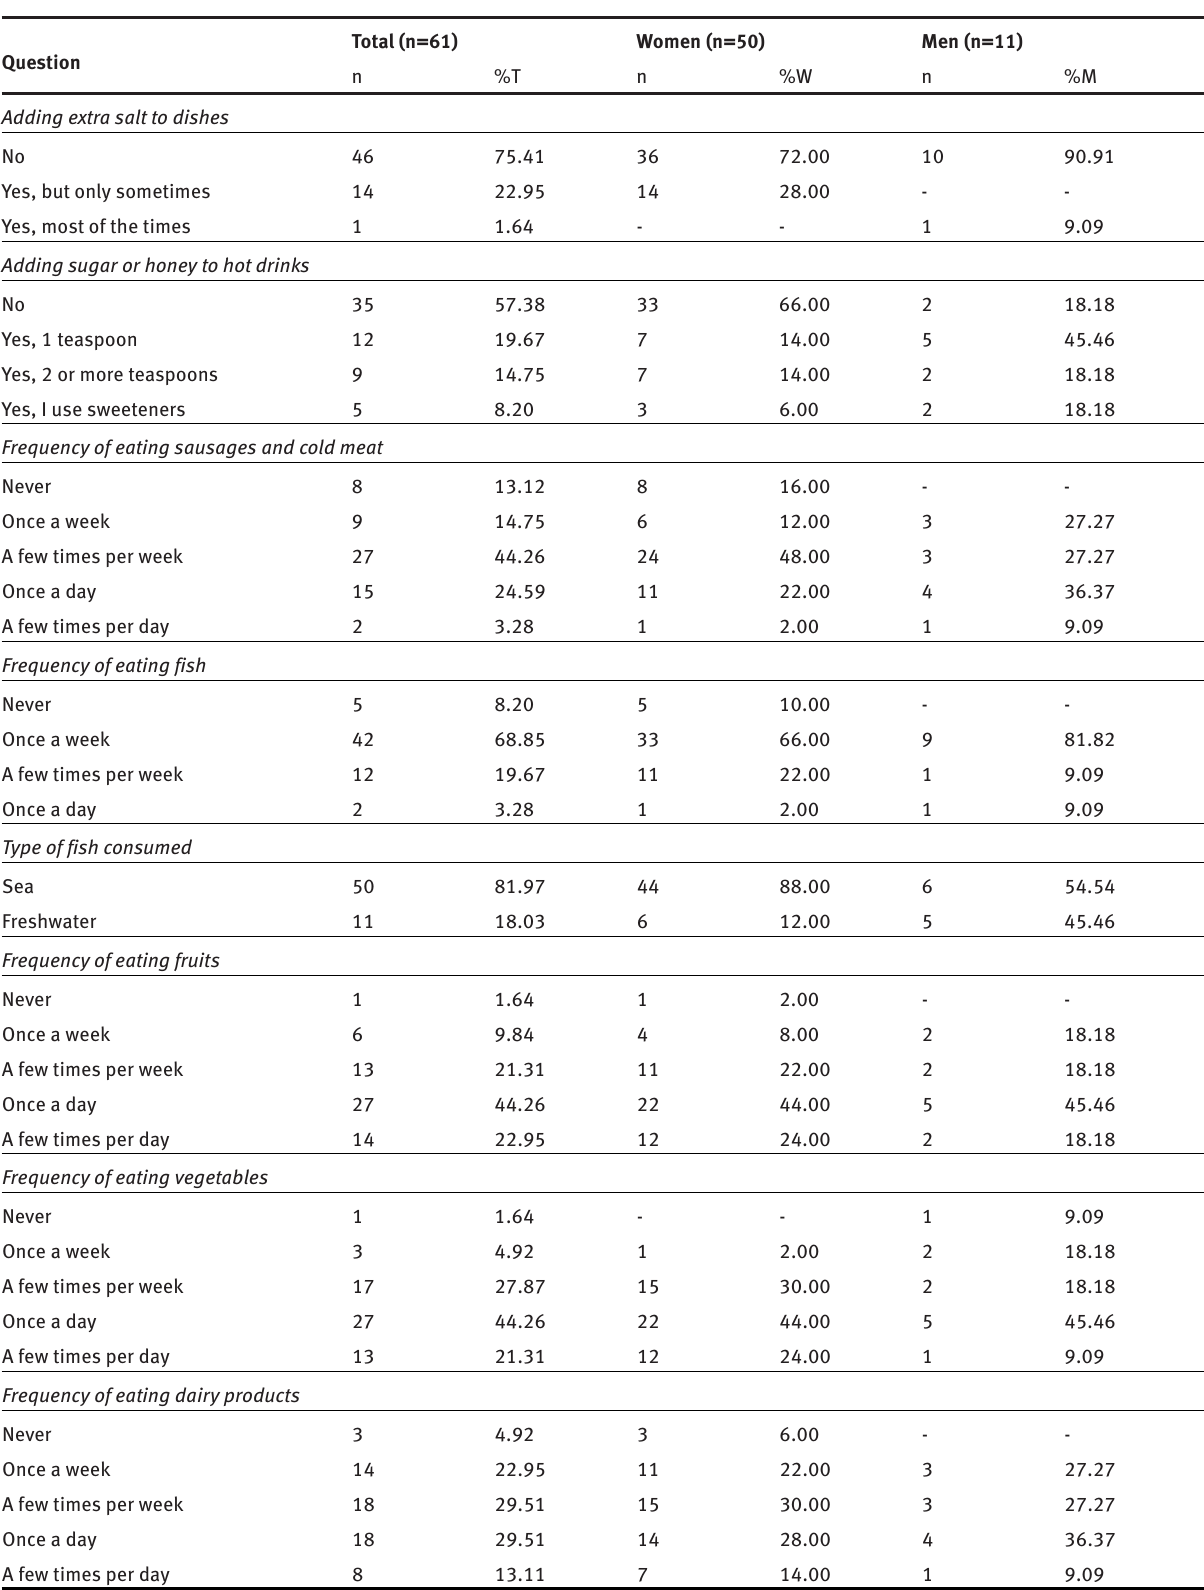
Table 5: Frequency of consumption of specific product groups of the respondents